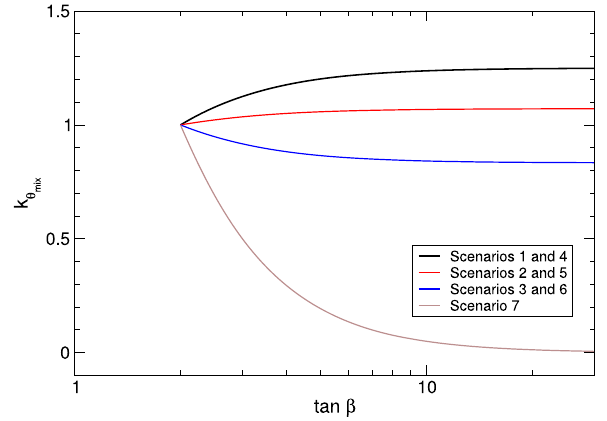
Fig. 1 Scale factor for the mixing angle θ mix , defined in Eq. (79), as a function of tan β in logarithmic scale